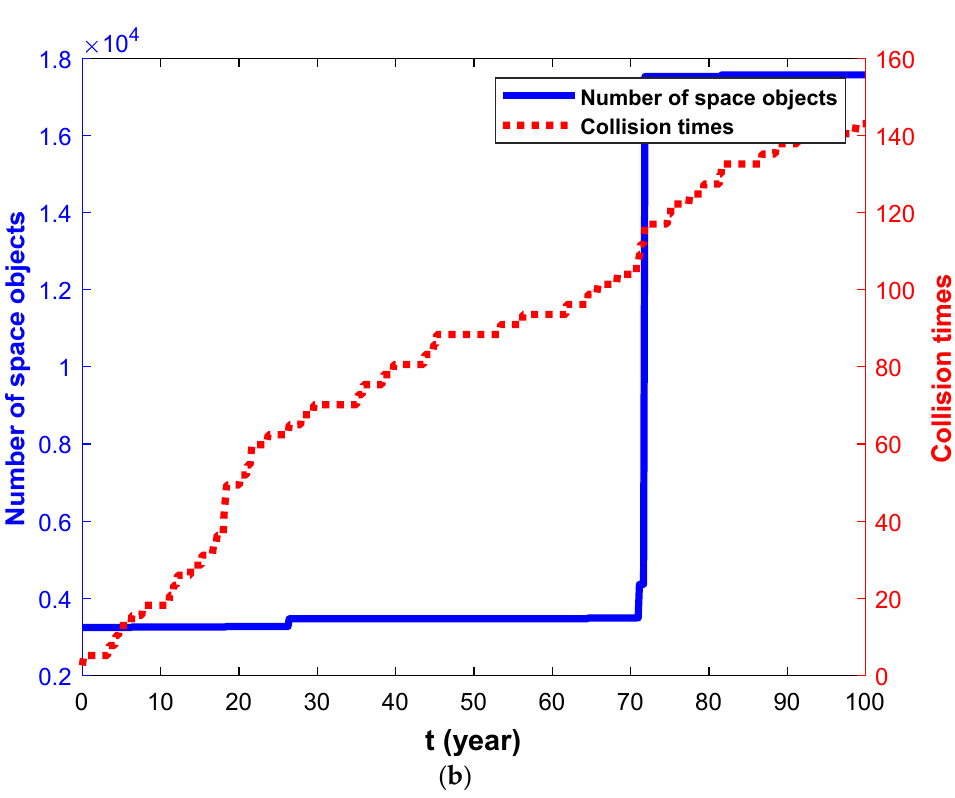
Figure 2. Two simulations of the first scenario: ( a ) simulation with the largest number of space objects after 100 years; ( b ) simulation with the smallest number of space objects after 100 years. Table 3. Classical orbital elements of space debris from GEO